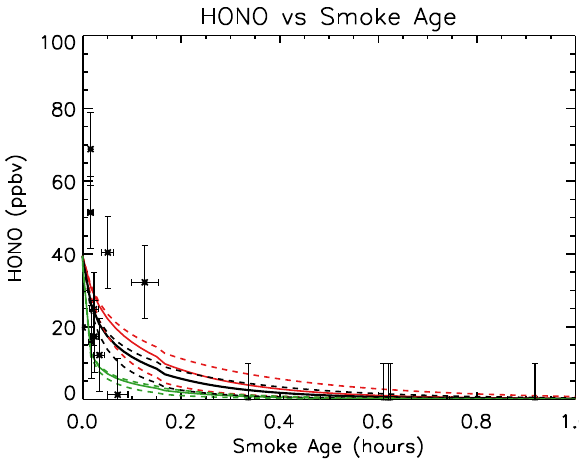
Figure 7. HONO mixing ratio (ppbv) vs. estimated smoke age for the first hour after emission (note difference in x axis scale from Figs. 4–6) when the chemistry of the unidentified SVOCs and a downwind HONO source is not included in the model. Asterisks are the measured mixing ratios, with the horizontal error bars show- ing the uncertainty in the estimated age and the vertical error bars showing the uncertainty in the measurement. Red, black, and green are ASP results for the slow, best fit (medium), and fast plume dilu- tion rates. Dashed lines are for above-plume photolysis rates, while solid lines are for the middle of the plume, and dotted lines are for the bottom of the plume (see the legend in Fig.